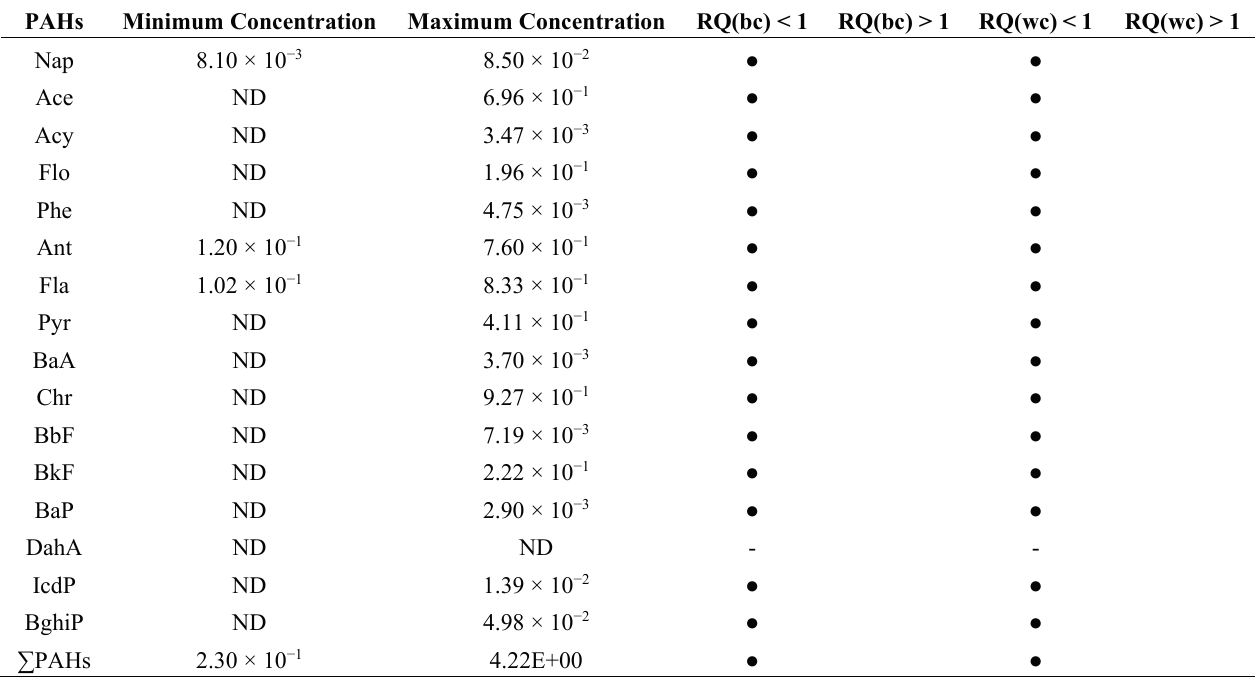
Table 3. Risk quotients for 16 PAHs ( μ g/L) in the water.